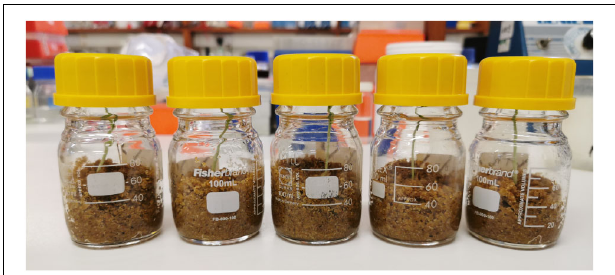
FIGURE 1 | In situ ARA vessels. Schott bottles contain 6-dpi barley plants with a headspace atmosphere of 1% O 2 and 10% C 2 H 2 .